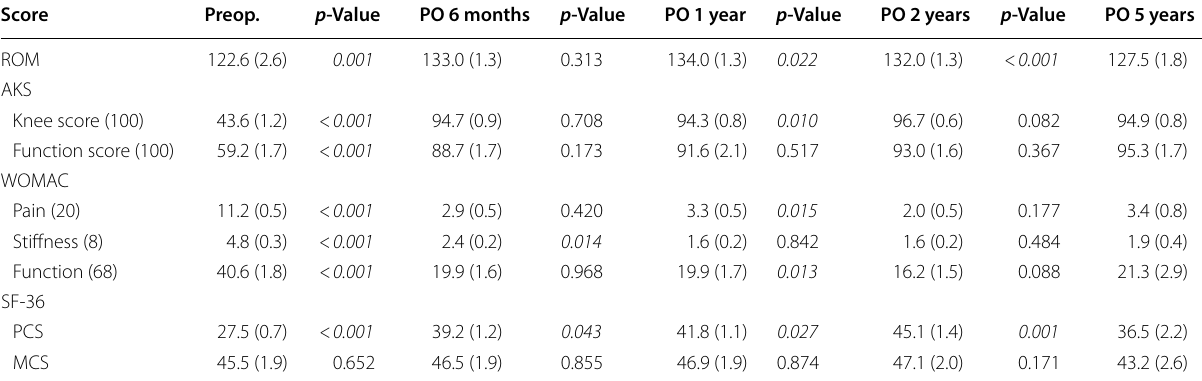
FB fixed bearing, Preop. preoperative, PO postoperative, ROM range of movement, AKS American Knee Society score, WOMAC Western Ontario and McMaster Universities Arthritis Index score, SF-36 36-Item Short Form Health Survey, PCS physical component summary, MCS mental component summary